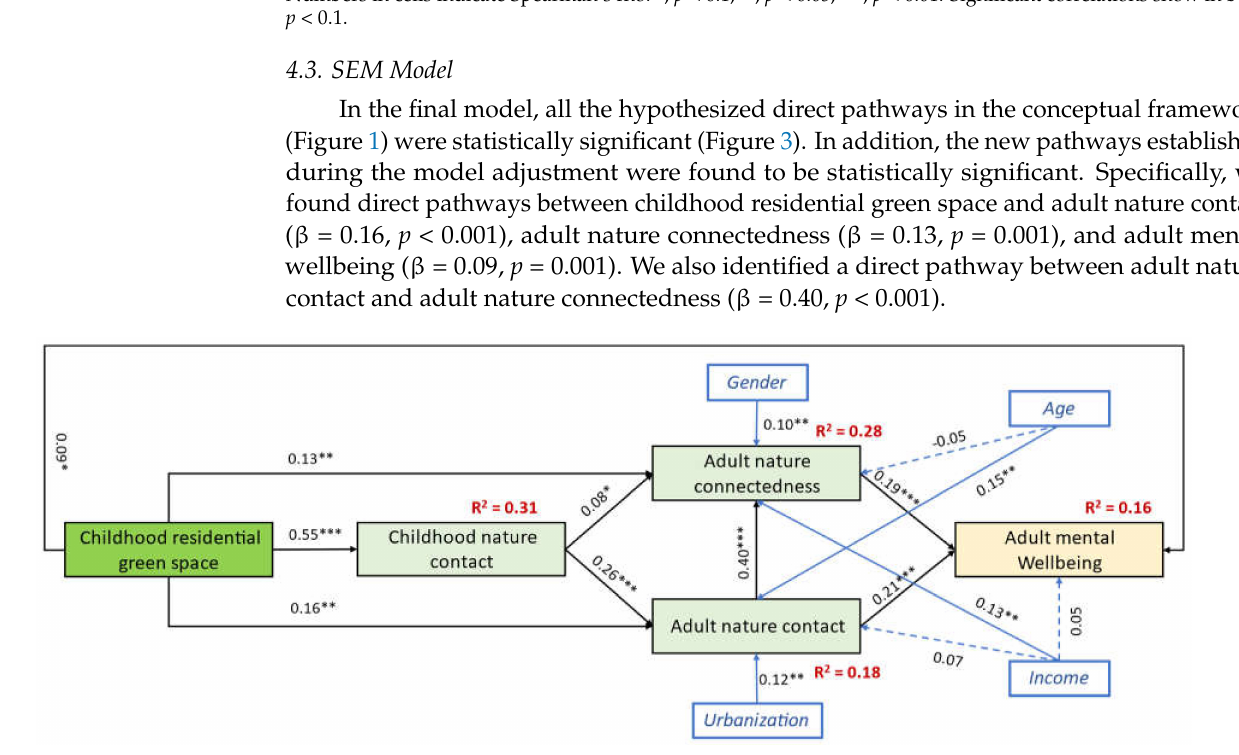
Figure 3. Final SEM with standardized coefficients ( β ). Solid lines indicate statistically significant pathways; dotted lines indicate statistically non-significant pathways. *, p < 0.05; **, p < 0.01; ***, p < 0.001. R 2 , explained